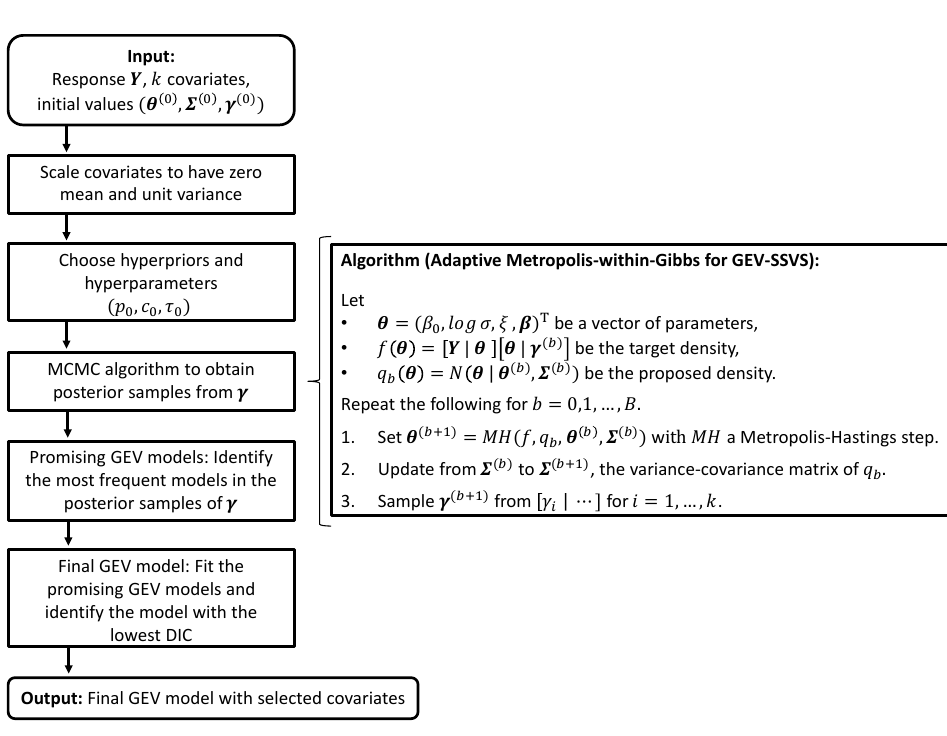
Figure 2. The framework of the GEV-SSVS method. Left : outline of the workflow. Right : outline of the iterative MCMC algorithm to obtain posterior samples of the model